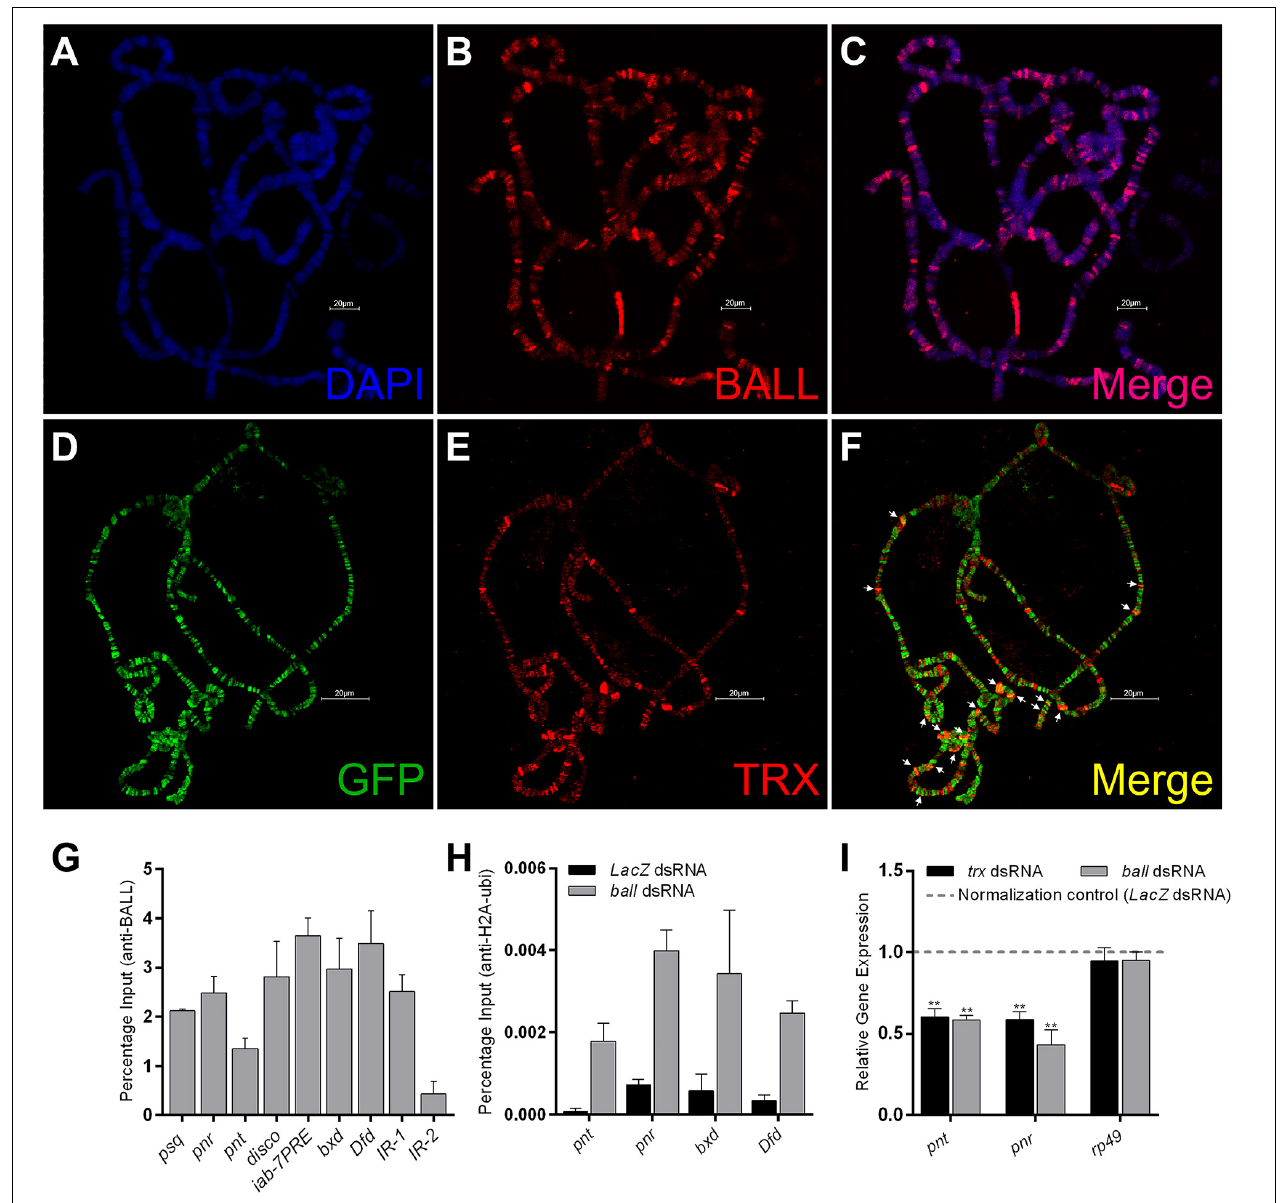
FIGURE 3 | BALL co-localizes with TRX at the chromatin and antagonizes PcG. (A–C) Polytene chromosomes from third instar larvae stained with DAPI (A) and BALL antibody (B) . (D–F) Third instar larvae expressing GFP-tagged BALL were stained with GFP (D) and TRX (E) antibodies. Co-localization of BALL and TRX is clearly seen at several loci [ (F) , white arrows]. (G) Strong enrichment of BALL at non-homeotic ( psq, pnr, pnt, and disco ) and homeotic ( iab-7PRE , bxd , Dfd ) trxG targets was observed by ChIP from wild-type Drosophila S2 cells using BALL antibody. IR-1 and IR-2 are intergenic regions not bound by TRX and served as controls (Papp and Müller, 2006). (H) ChIP from BALL depleted cells showed enhanced H2AK118ub1 levels at non-homeotic ( pnt , pnr ) and homeotic ( bxd , Dfd ) targets of trxG as compared to cells treated with dsRNA against LacZ . (I) Using qRT-PCR, relative gene expression of pnt and pnr was analyzed in cells after ball or trx knockdown. LacZ dsRNA treated cells were used as normalization control (dashed line) and the expression of pnt and pnr in ball and trx depleted cells was plotted. BALL depleted cells showed a significantly decreased expression of pnt and pnr similar to the cells with trx knockdown. The mRNA levels of a ribosomal protein, rp49 , served as a negative control. Independent t -tests were performed for analyzing relative expression of each gene (* p ≤ 0.05, ** p ≤ 0.01, *** p ≤ 0.001, or **** p ≤